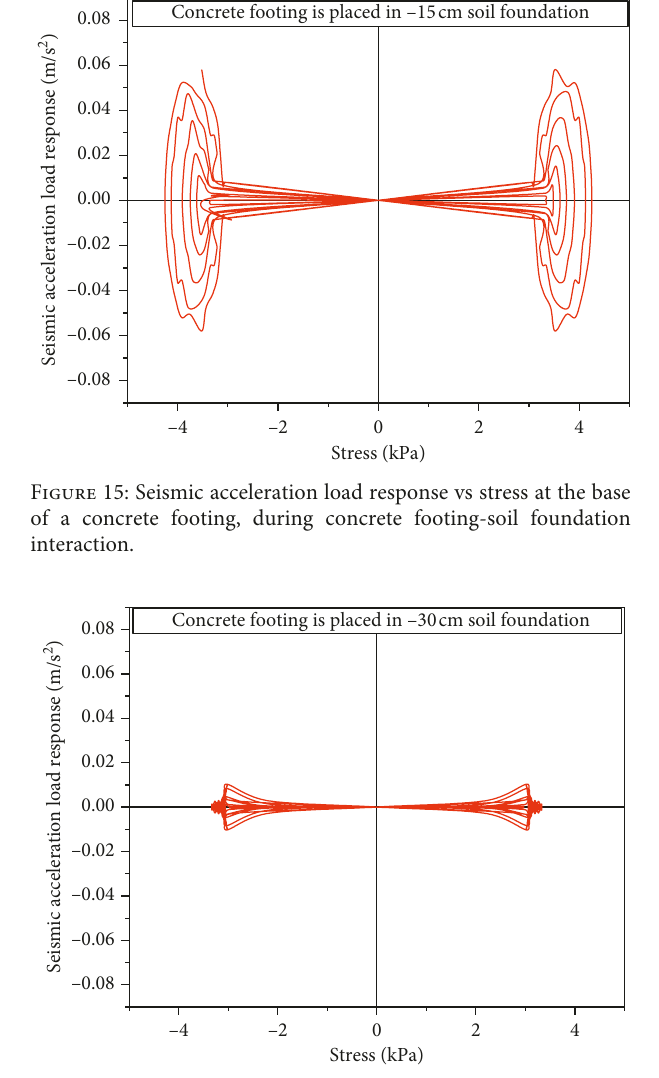
Figure 16: Seismic acceleration load response vs stress at the base of a concrete footing, during concrete footing-soil foundation interaction.